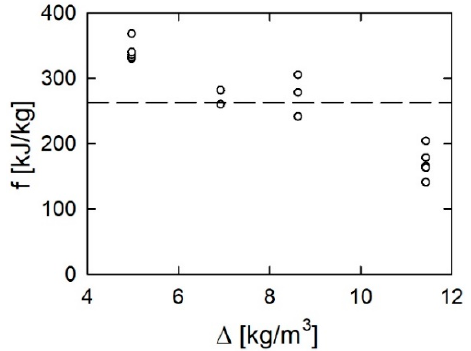
Figure 8. Estimated values of the force (the dashed line is the mean value) (modified method: approach 2).